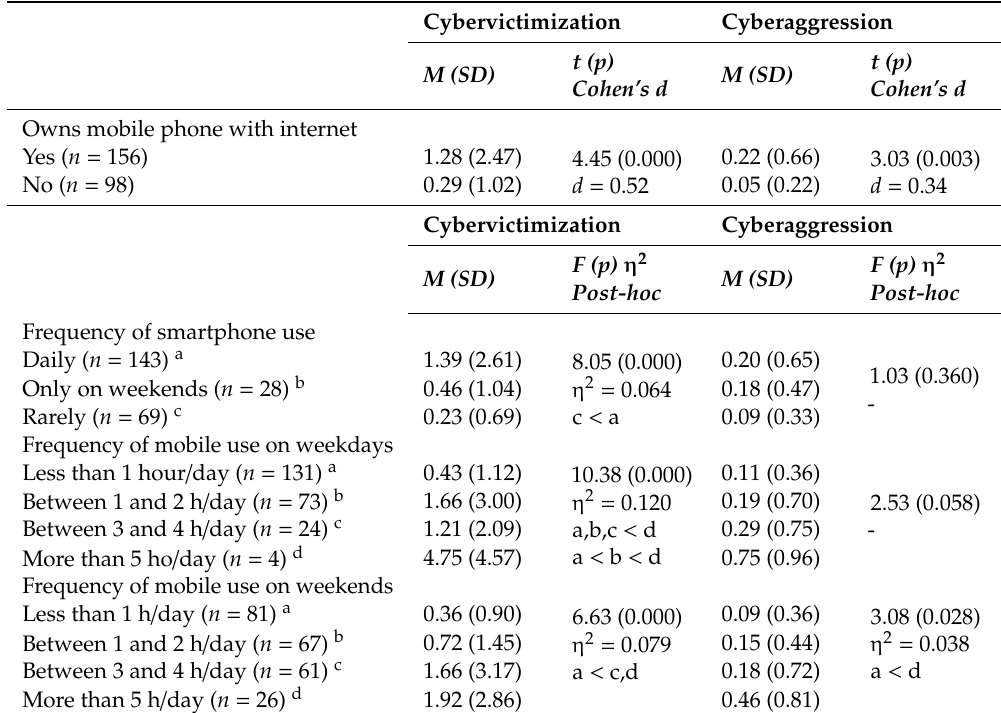
Table 5. Comparison of scores on cybervictimization and cyberaggression as a function of frequency of smartphone use, weekday and weekend hours of use and possession of mobile phone.